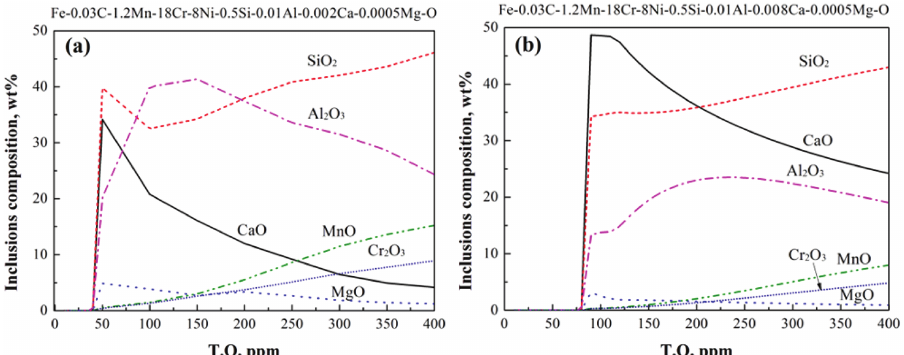
Figure 6: Inclusion composition as a function of the total oxygen content by using FactSage